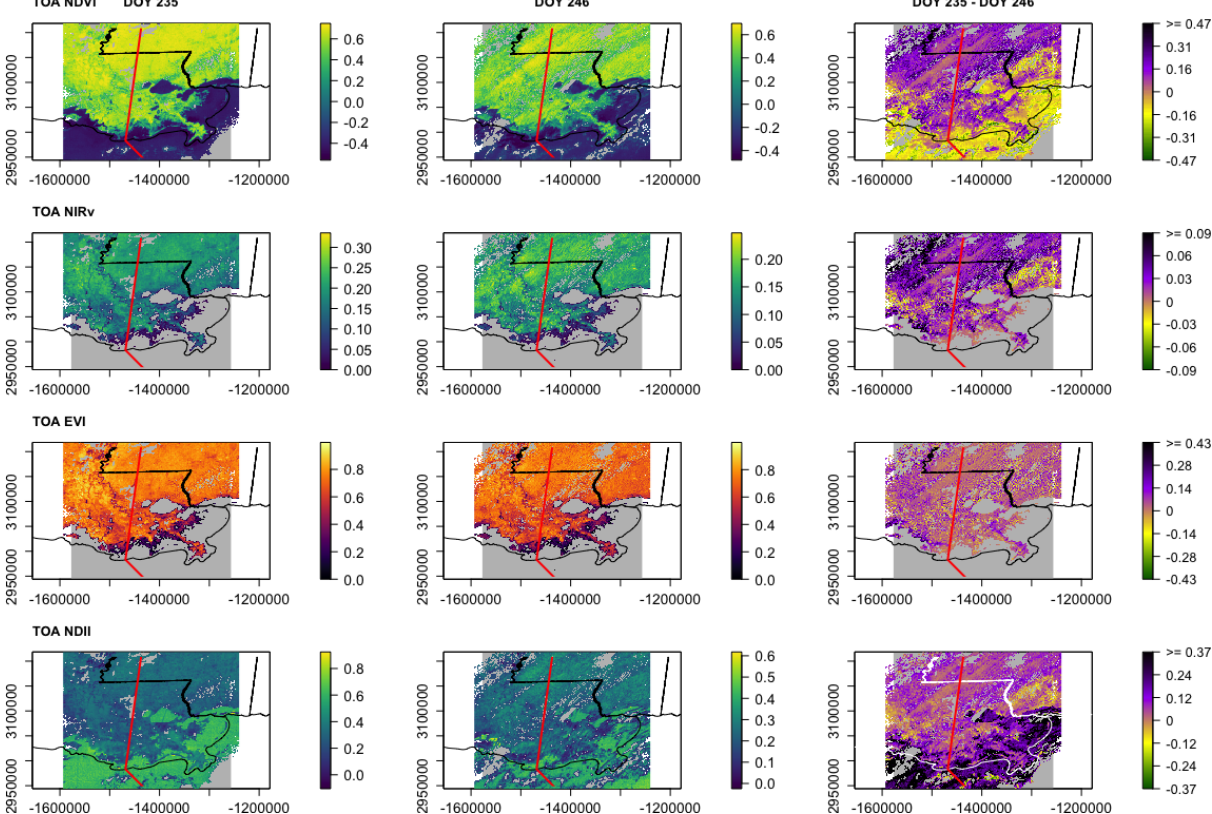
Figure 6. TOA NDVI, near-infrared reflectance of vegetation (NIRv), Enhanced Vegetation Index (EVI), and NDII calculated using the TOA reflectance factors from GOES-16 imagery for DOY 235 (22 August 2020) at 16:00UTC, DOY 246 (2 September 2019) at 16:00UTC, and their difference around the advisory track for Hurricane Laura (red line) in southern Louisiana (26 August 2020; DOY 239). Gray pixels represent cloudy pixels from the GOES Clear Sky Mask algorithm or vegetation index values below 0 for NIRv and